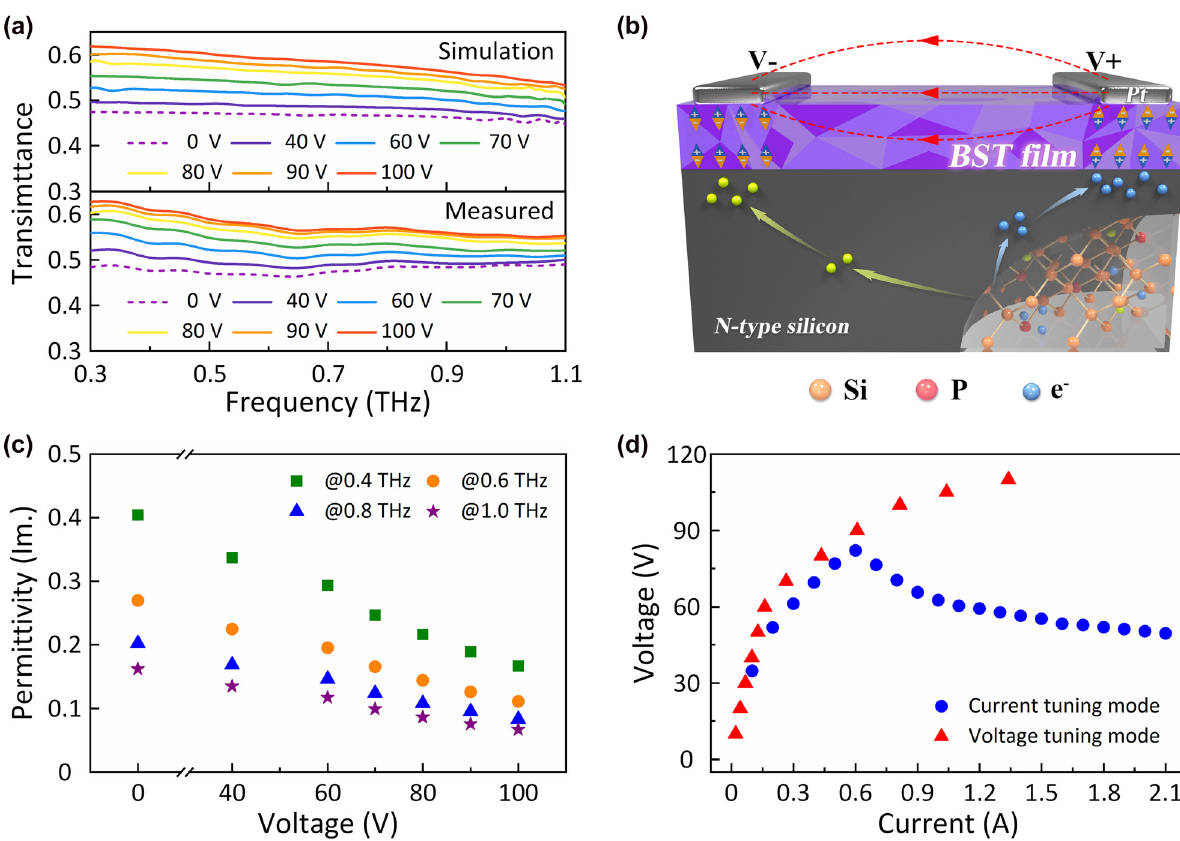
Figure 3: Voltage tuning mode (a) Simulated and measured transmittance of the hybrid meta-modulator under different bias voltages. (b) Operating schematic illustration of the meta-modulator under the voltage tuning mode. (c) Voltage dependence of the imaginary part of the effective permittivity for our design at different frequencies. (d) Measured voltage – current relation of our design under current tuning mode and voltage tuning